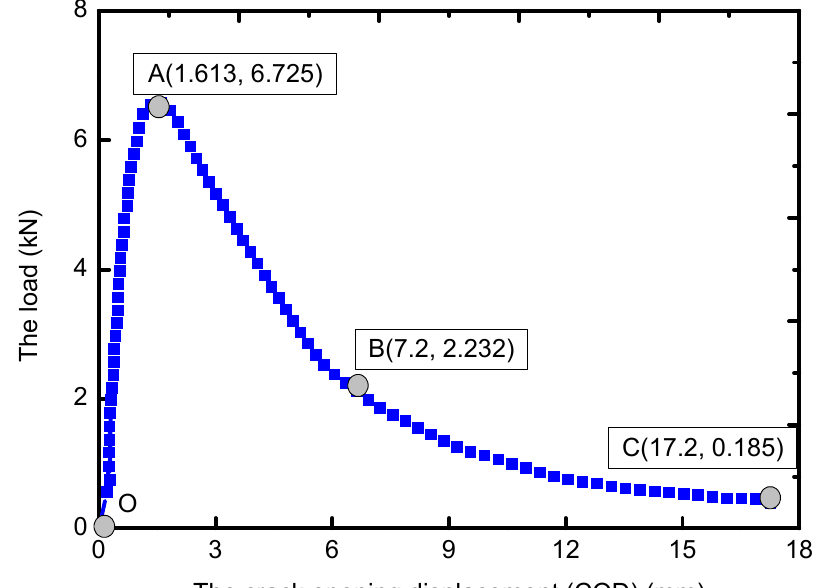
Figure 6. The variation of load with COD for the concrete beam without CFRP